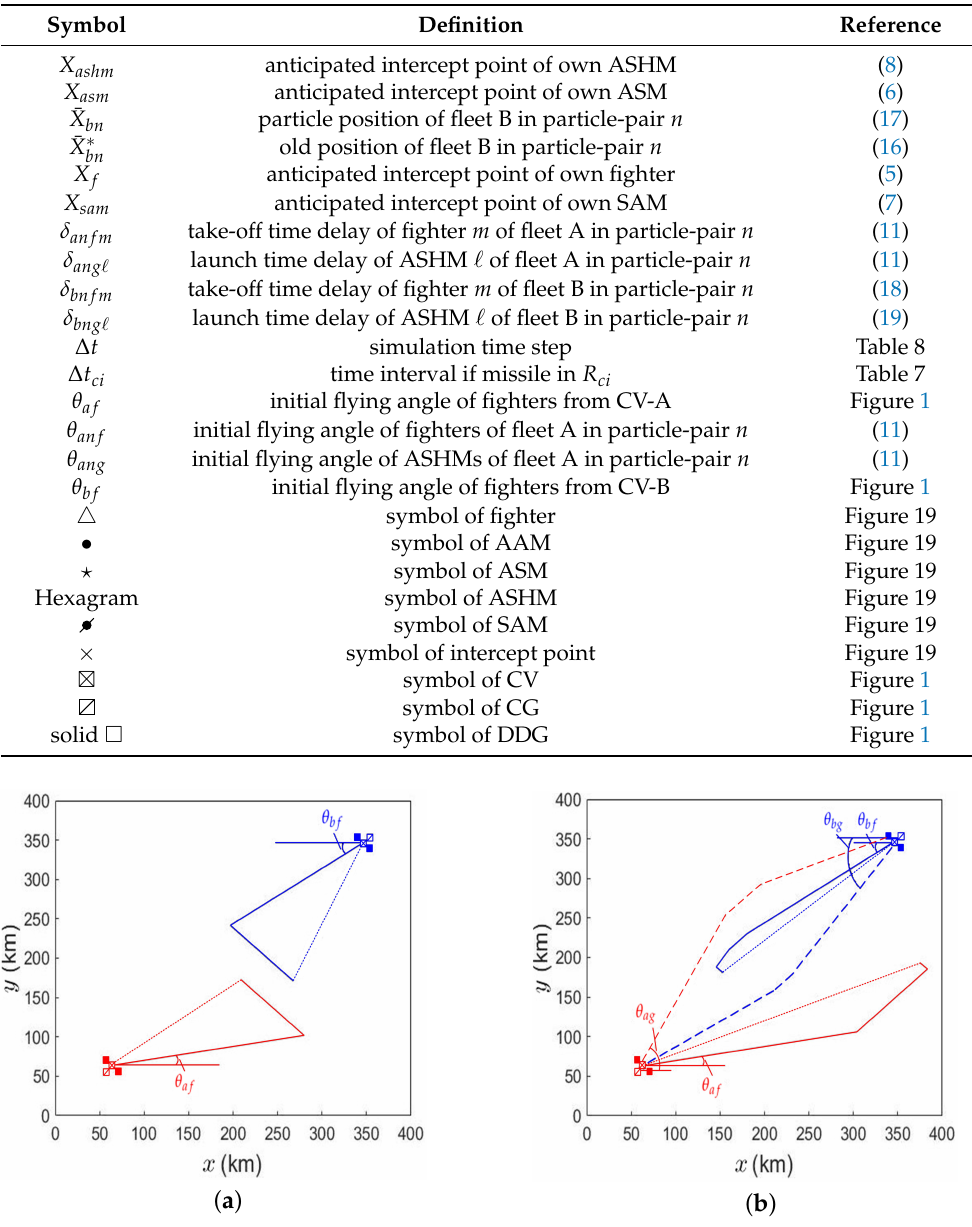
Figure 1. Examples of game scenario, ( a ) defense option, ( b ) attack option, red marks for fleet A and blue marks for fleet B, square with cross: CV, square with slash: CG, solid square: DDG, ———: fighter forward path, · · · · · · : fighter return path, − − − : ASHM